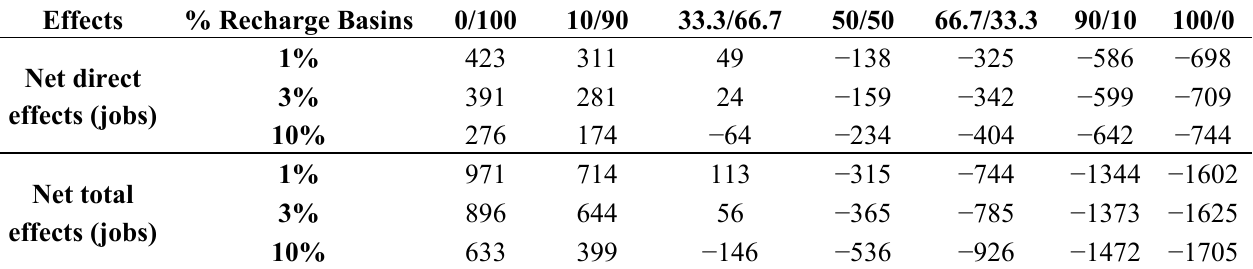
Table 8. Direct and total effects of Table 6 scenarios on employment in a 1000 m land use